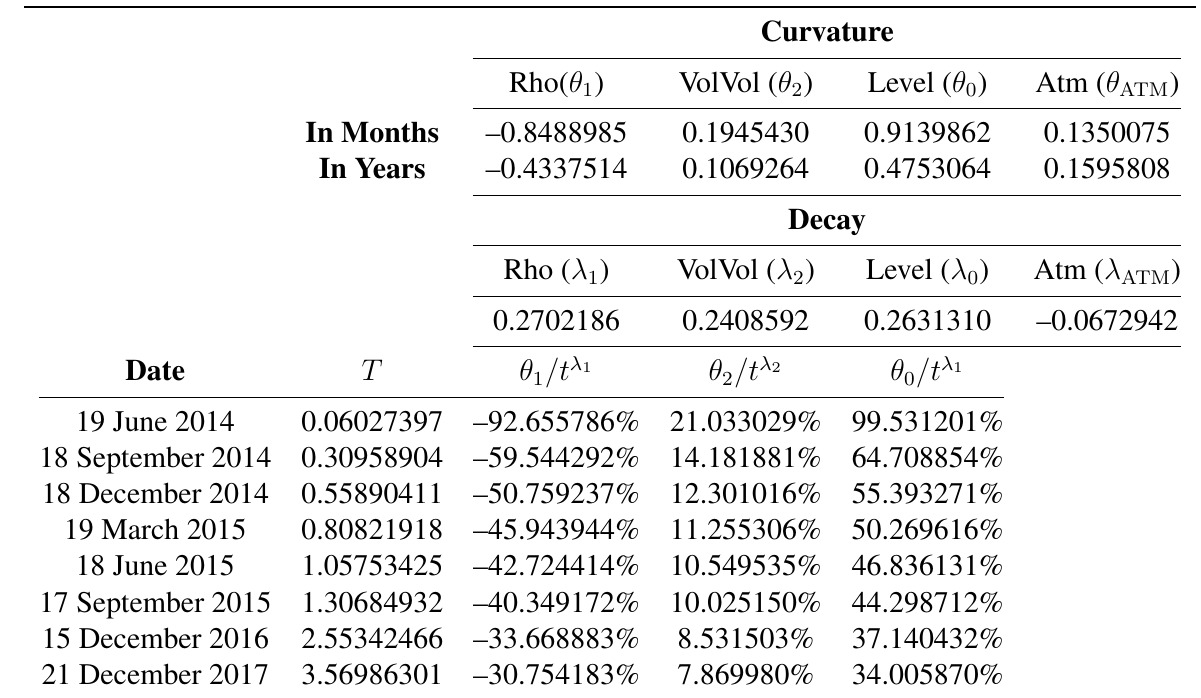
Table 2. Optimized parameters for the ALSI deterministic implied volatility function on 28 May 2014 (see Equations (4.24)–(4.26)).